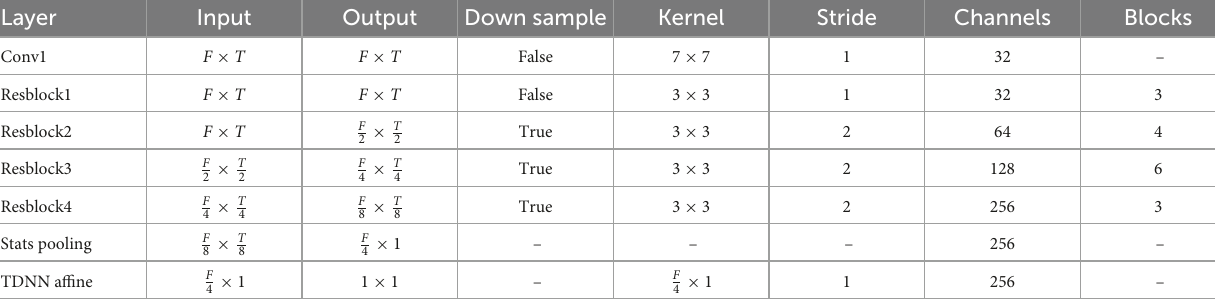
TABLE 3 Resnet encoder